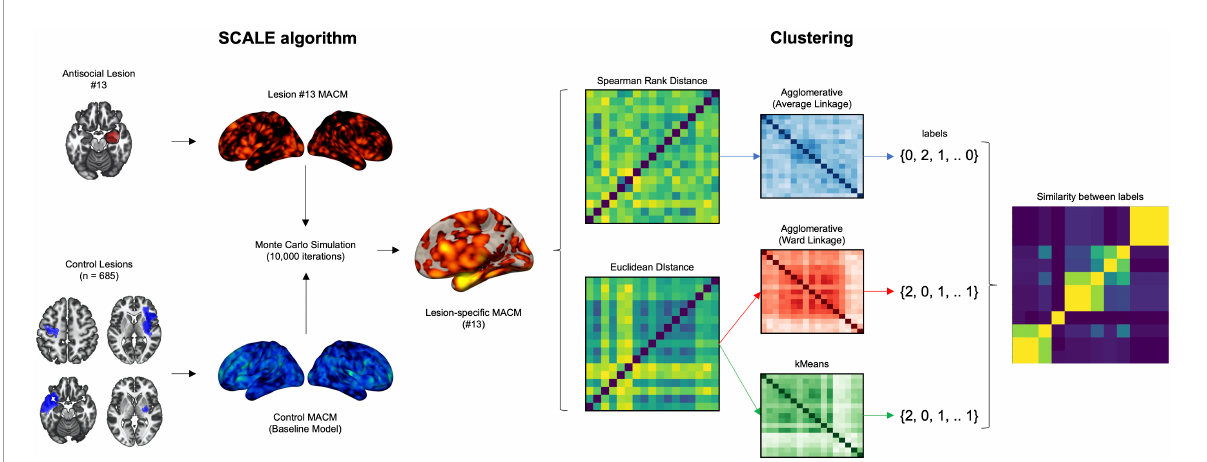
FIGURE2 Workflow of the analyses to examine the heterogeneity in lesion network associated with antisocial behaviors. Investigating disentangling the heterogeneity of meta-analytic networks across lesion underpinning antisocial behaviors. Experiments that reported activation foci within each of the antisocial lesion were identified and compared 10,000 times to a null distribution of control lesion (stroke dataset). Pairwise distances (Spearman Rank and Euclidean) were computed between the resulting voxelwise z-score maps. Agglomerative and kMeans clustering methods were run to extract homogenous subgroups of